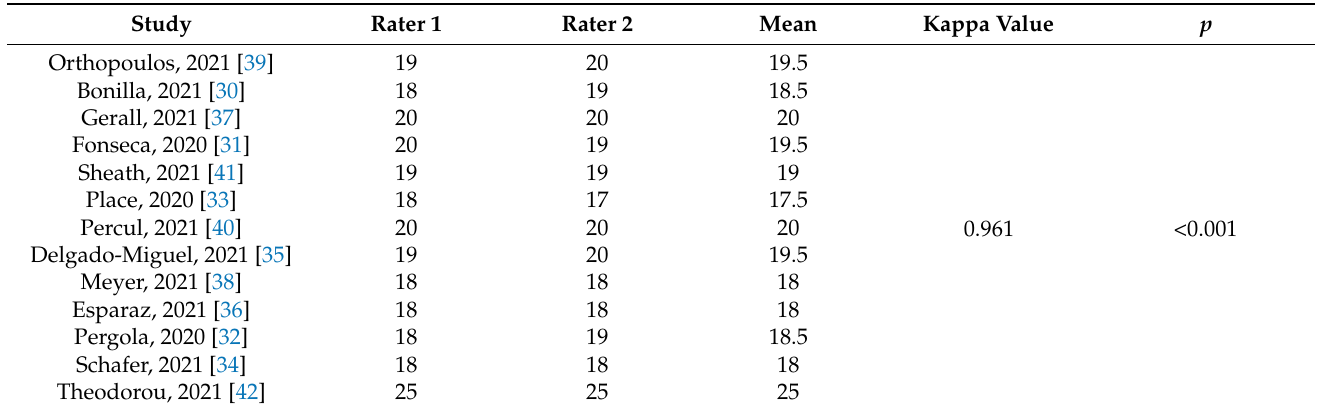
Table 3. The total scores and inter-observer agreement.